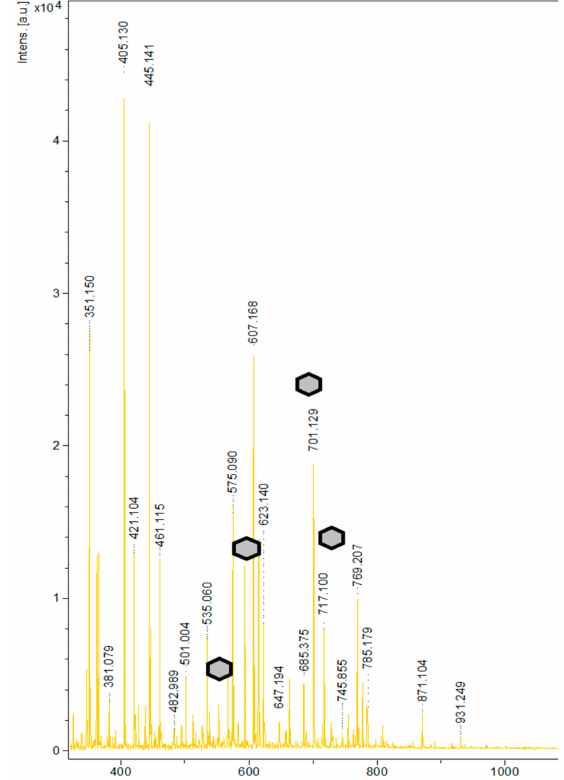
Figure 5. MALDI-TOF MS spectrum of the reaction mixture from the acylation of inulin acetals with HPPA, catalyzed by Novozyme 435, after 72 h of reaction. Identified acetals (sodium adducts) of aromatic esters formed with isopropylidene derivatives of inulin are marked with